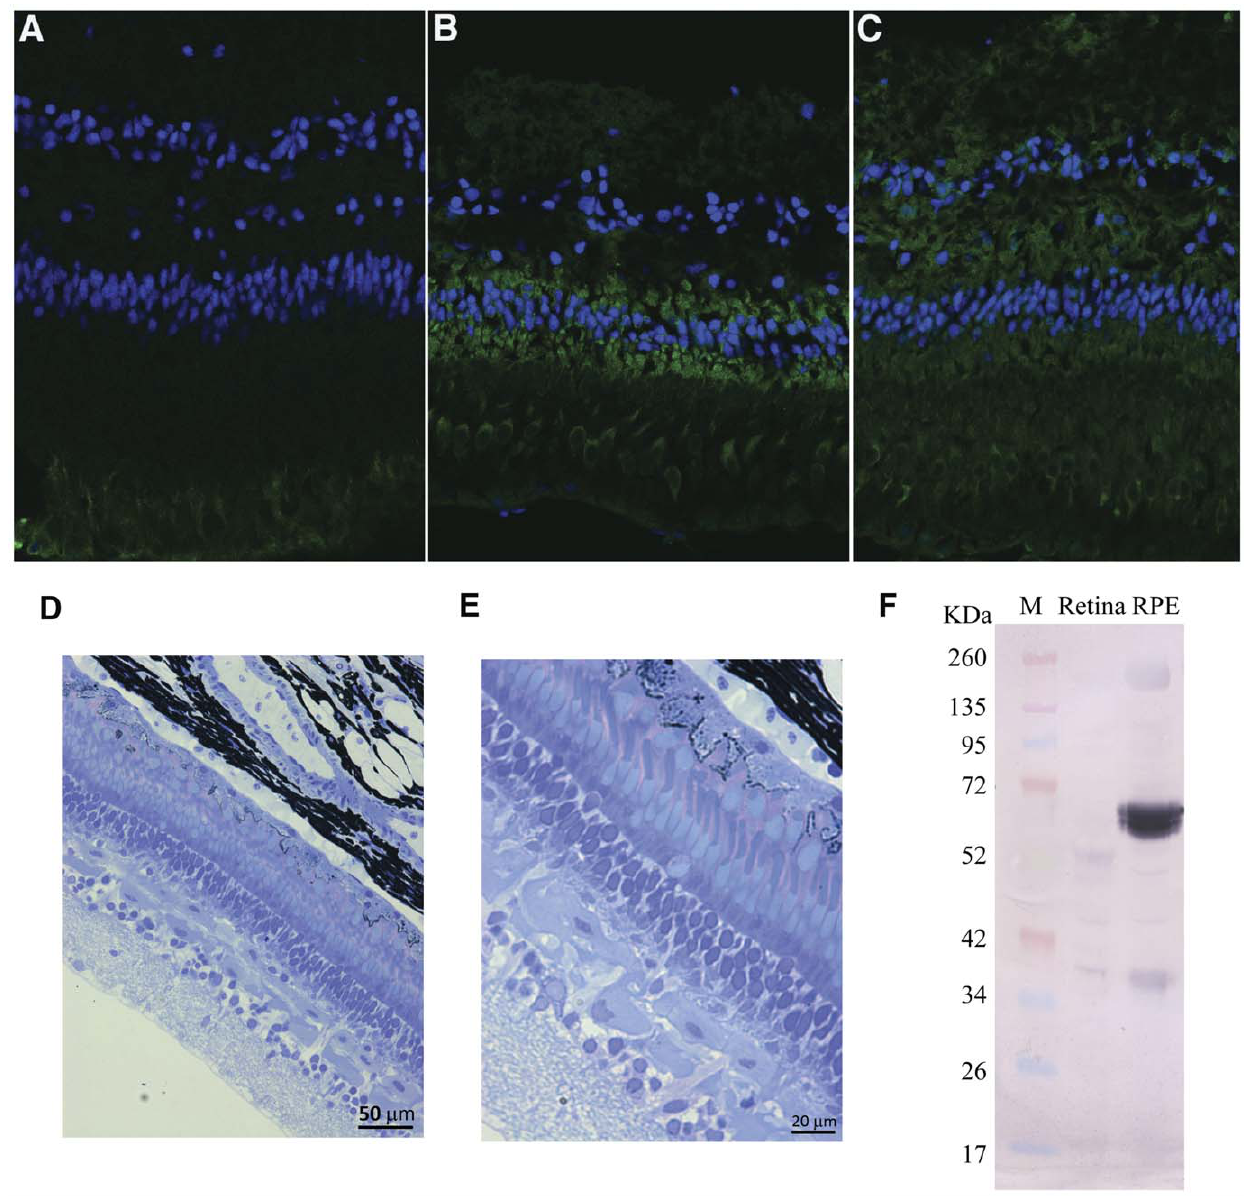
Figure 7. Localization of RPE65 in the Lamprey RPE/retina. Cy3 (green) staining of frozen sections of fixed lamprey retina/RPE with rabbit polyclonal antibodies to A: RPE65; B: arrestin; C: blue cone opsin SWS2 [38,39]. Nuclear DAPI staining in blue. Lamprey retina histology D: 20X magnification; E: 40X magnification of semithin sections stained with toluidine blue. F: Immunoblot of Lamprey retina and RPE extracts. Retina and RPE were prepared as described in Methods. Lanes from left to right: lane 1 , marker Spectra Multicolored Broad Range Protein ladder (Fermentas), lane 2 , retina extract, lane 3 , RPE extract.